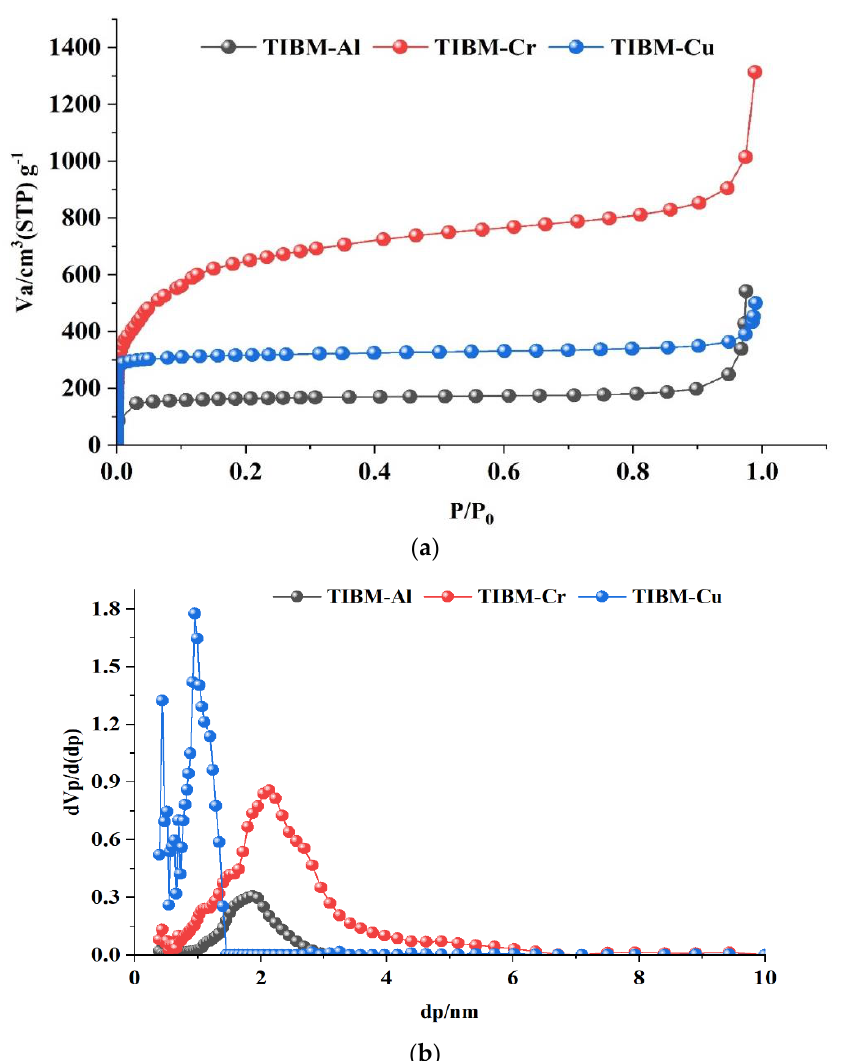
Figure 1. ( a ) N 2 adsorption isotherms and ( b ) pore size distribution of TIBM-Al, TIBM-Cr, and MOF-Cu at 77